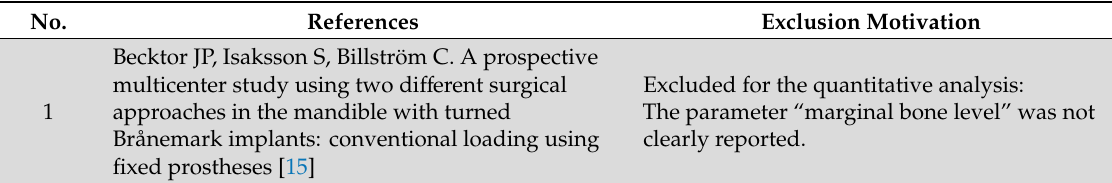
Table 1. Excluded articles after full-text screening; the articles marked in grey rows were included for qualitative analysis, but not quantitative one [15–42] .